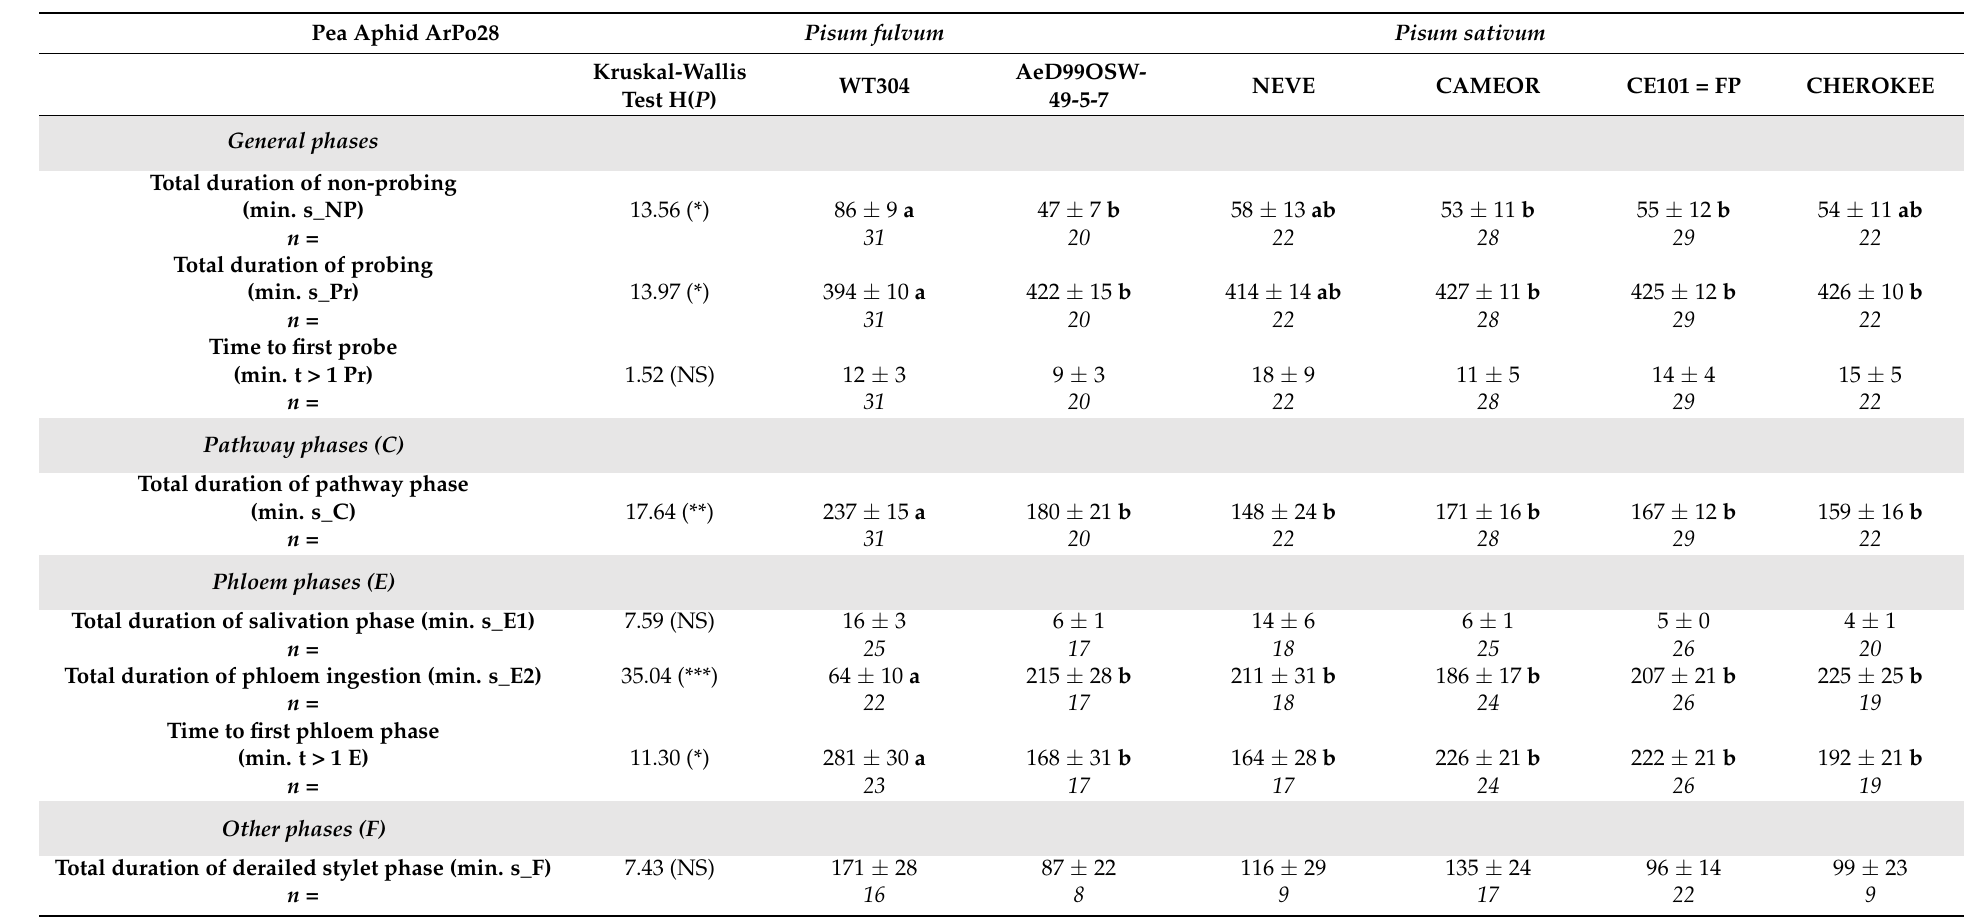
Table 1. Electrical penetration graph parameters (means ± SEM) calculated for A. pisum pea biotype (ArPo 28 clone) during an 8 h monitoring session on different genotypes of P. sativum and on P. fulvum